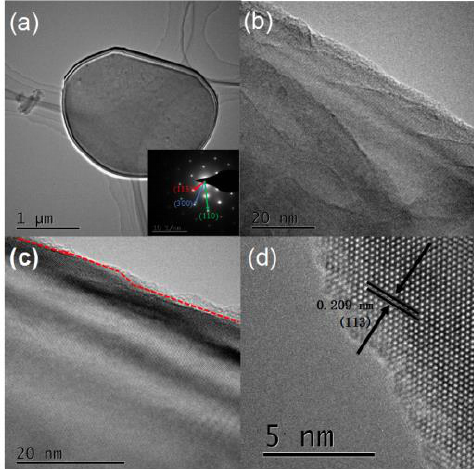
Figure 6. ( a , b ) TEM images of uncoated α -Al 2 O 3 . ( c , d ) HRTEM images of α -Al 2 O 3 .